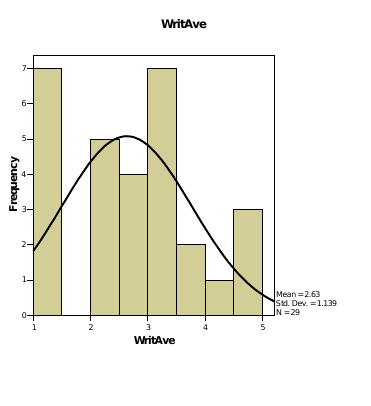
Histogram of the Writing Subtest Scores for All Levels ( N =29)